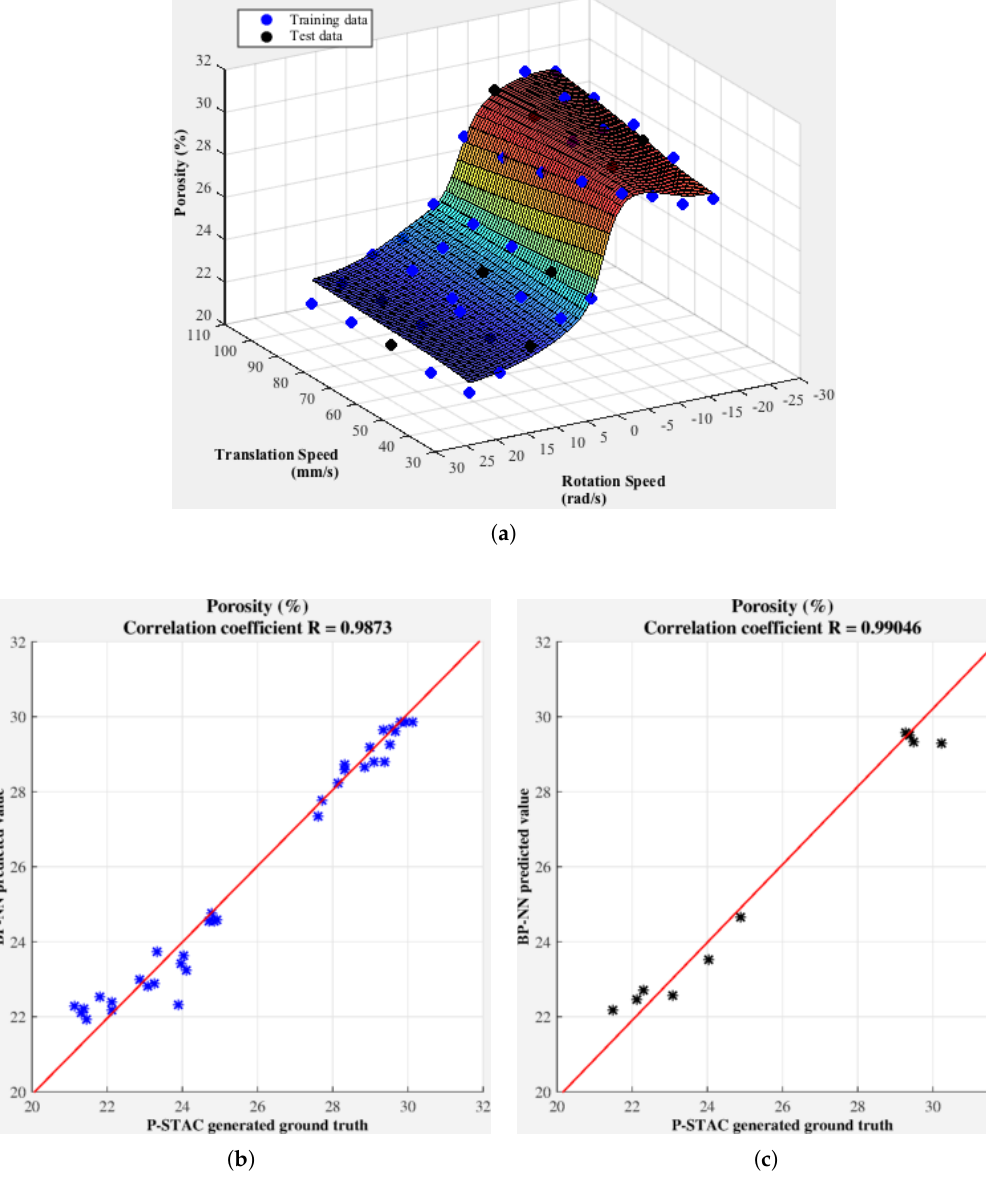
Figure 9. BP-NN predictions for the spreadability metric of spread layer porosity, Φ for the case of spreading Ti-6Al-4V powder on an additively manufactured spreading substrate with S q = 79 µ m ( a ) Regressed surface ( b ) Training data ( c ) Test